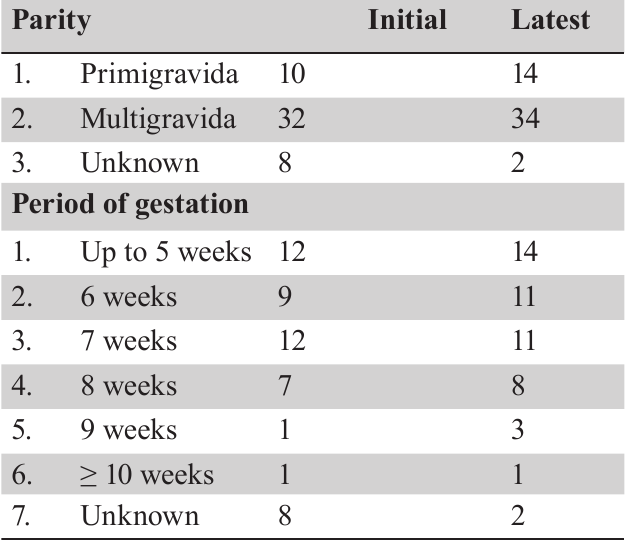
Table 4: Parity and gestational age of ectopic pregnancy